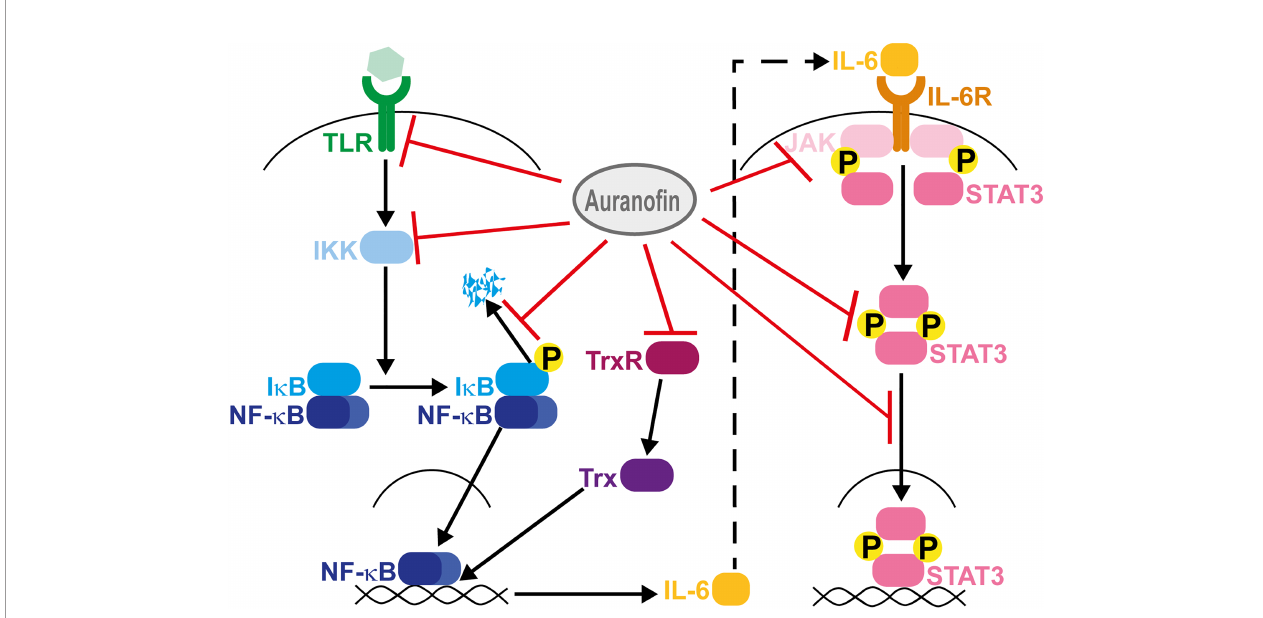
FIGURE 1 | Mechanisms of action of aurano fi n. Aurano fi n inhibits dimerization of toll-like receptor (TLR) 4, activation of I k B kinase (IKK), degradation of I k B, IL-6- induced phosphorylation of Janus kinase 1 (JAK1) and signal transducer and activator of transcription 3 (STAT3), and STAT3 translocation to the nucleus. In addition, aurano fi n inhibits thioredoxin reductase (TrxR) and, consequently, TrxR-dependent activation of thioredoxin (Trx); aurano fi n therefore inhibits the Trx-induced promotion of NF- k B